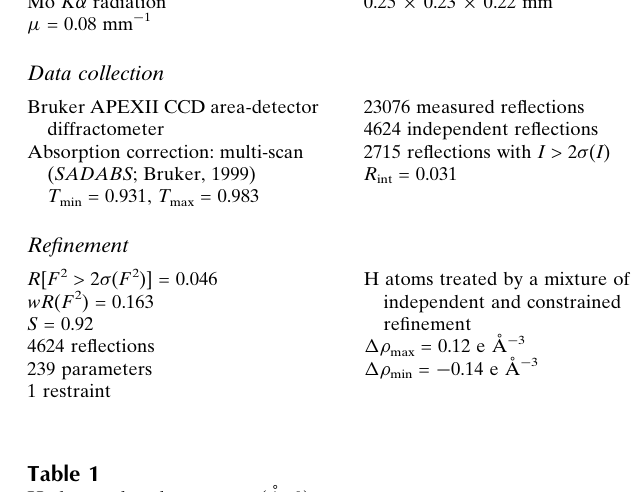
Hydrogen-bond geometry (A˚ , (cid:1)